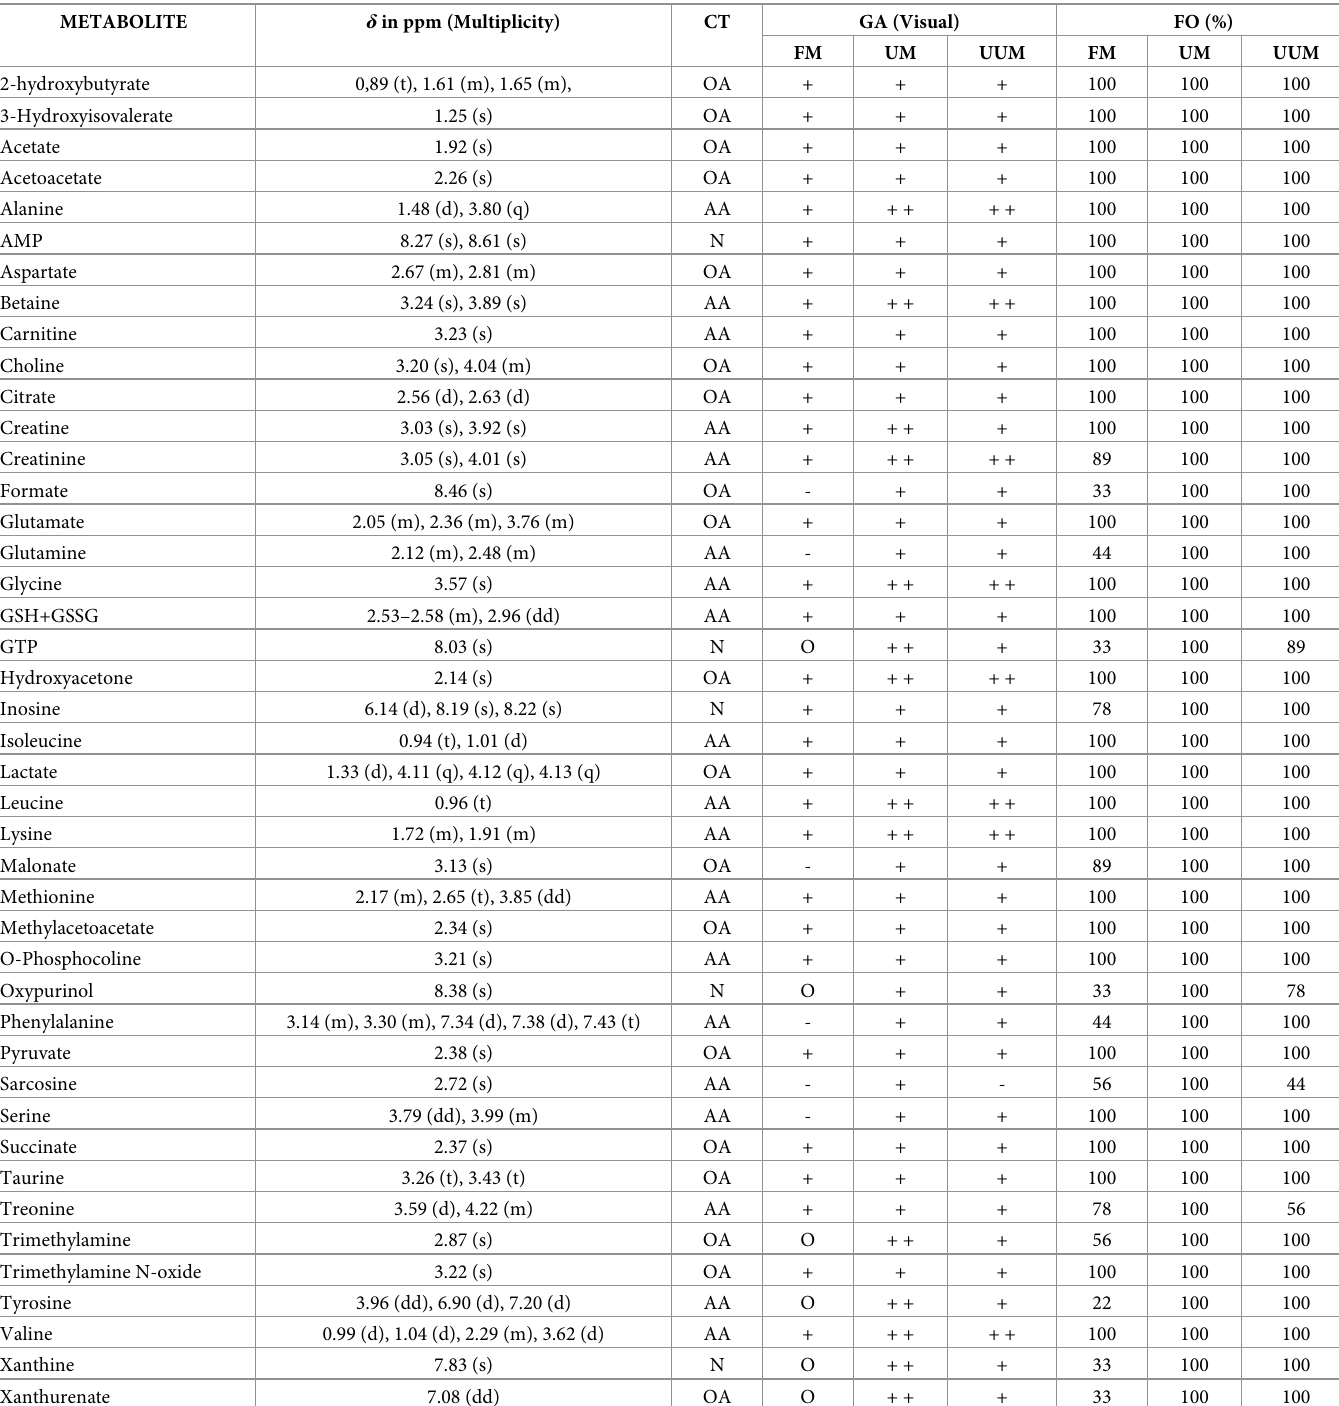
Table 1. List and detail of the metabolites assigned in the different methods evaluated.